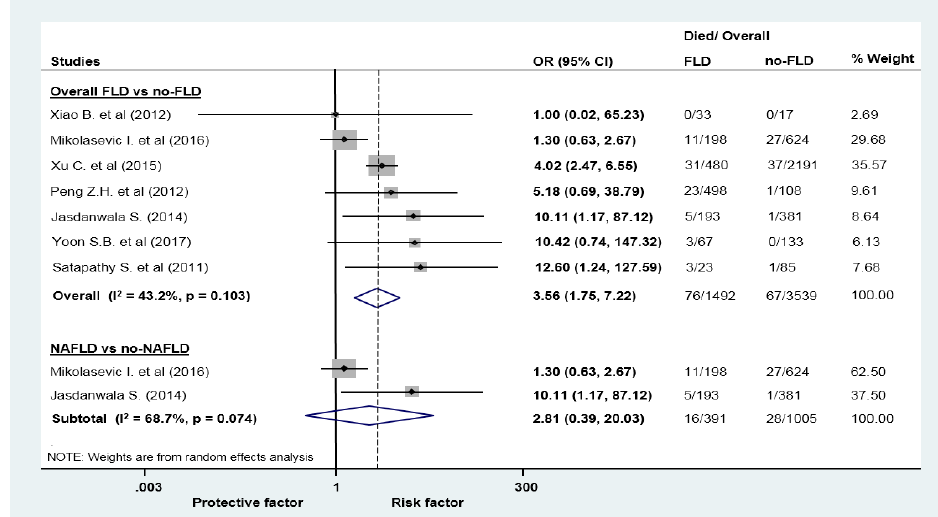
Figure 2. Forest plots of studies evaluating the association between fatty liver disease or non-alcoholic fatty liver disease and overall survival of patients with acute pancreatitis; CI: confidence interval, OR: odds ratio.